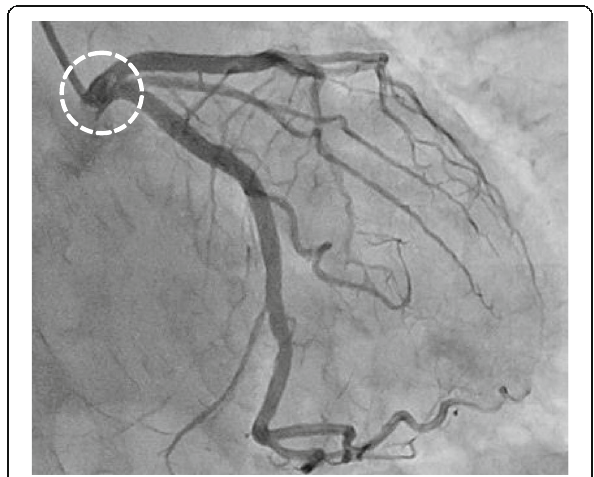
Fig. 2 Preoperative coronary angiography. Left coronary ostium did not show significant stenosis ( dotted circle )